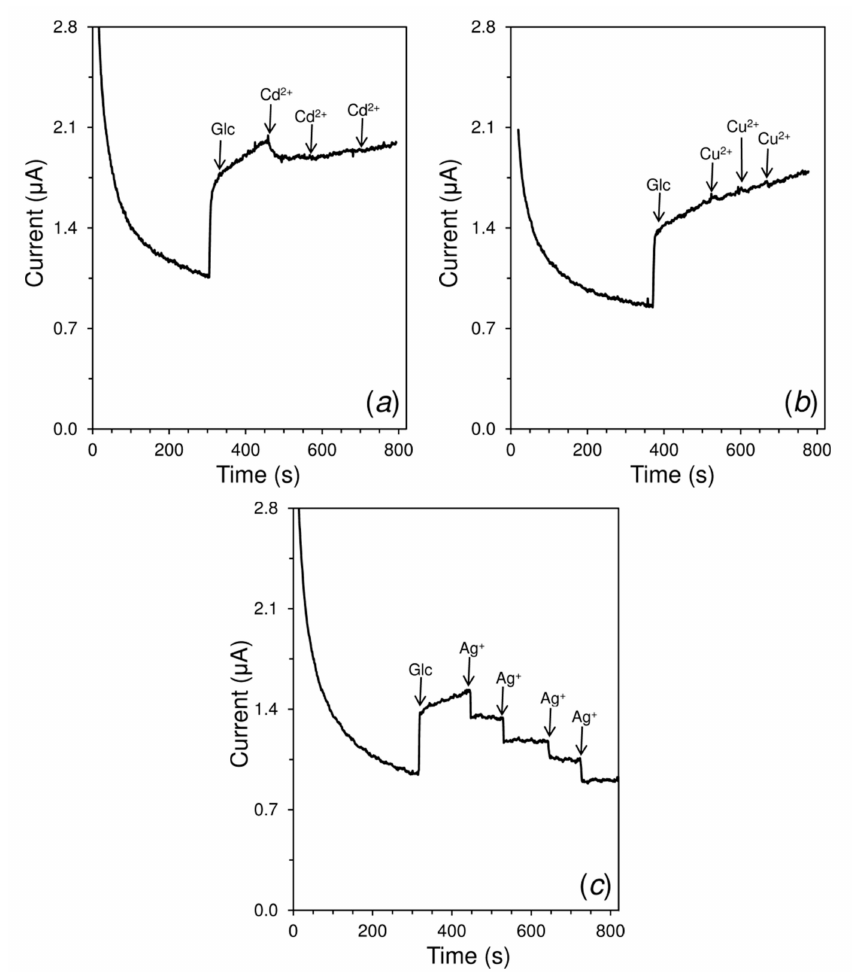
Figure 7. Amperometric responses of 200 µ M glucose with consecutive additions of 50 µ M Cd 2 +